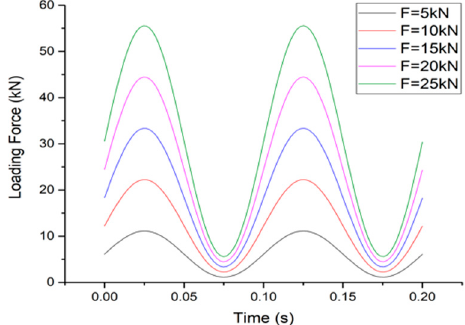
Figure 7. Amplitude scanning loading curve.